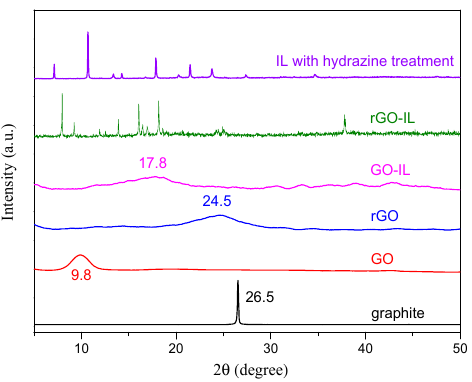
Figure 2. X-ray di ff raction (XRD) patterns of graphite, GO, rGO, GO-IL, rGO-IL, and IL with Figure 2. X-ray diffraction (XRD) patterns of graphite, GO, rGO, GO-IL, rGO-IL, and IL with hydrazine treatment. hydrazine treatment. Table 2. Summary of parameters from XRD Table 2. Summary of parameters from XRD patterns.